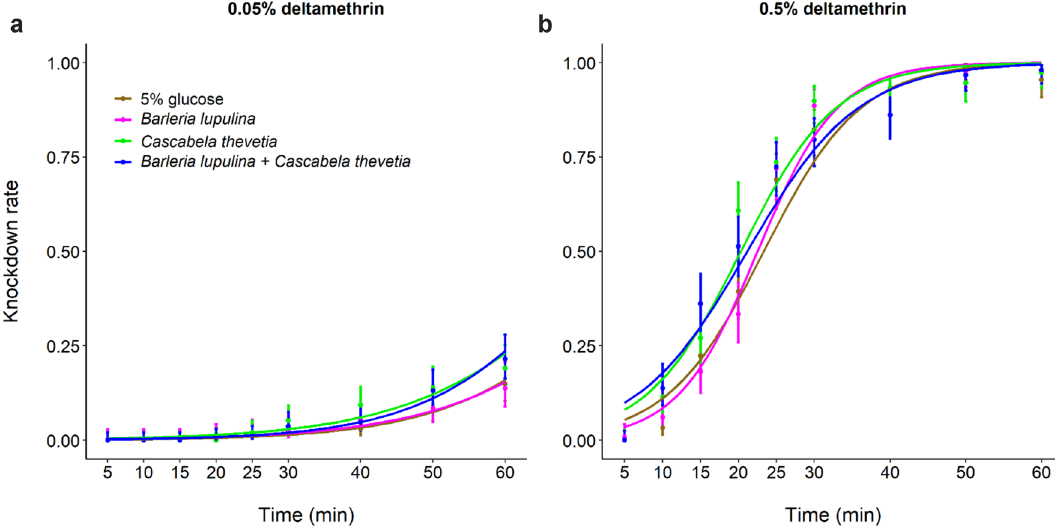
Figure 1. Effect of plant diet on mosquito knockdown rate (KD) following exposure to 0.05% deltamethrin ( a ) or 0.5% deltamethrin ( b ) over time for the two replicates. The lines represent best-fit logistic growth curves for each plant